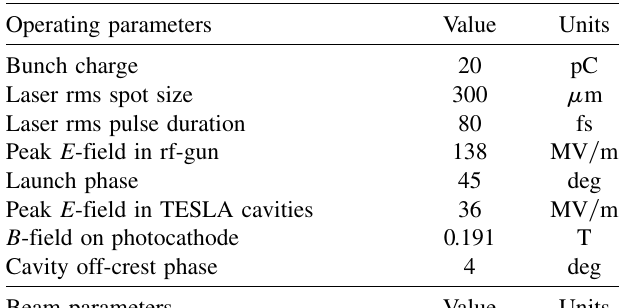
TABLE I. Operating parameters and achieved beam parame- ters at the photoinjector end.